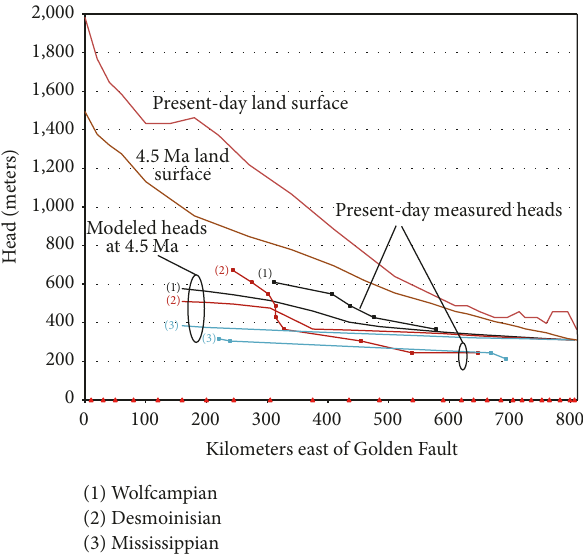
Figure 30: Results of running the fifth model, the 4.5 Ma model, representingthe2.5-million-yearperiodfrom7to4.5 Ma,compared to present-day heads. Model curves (1) , (2) , and (3) (Wolfcampian, Desmoinesian, and Mississippian, resp.) are further approaching the present-day data curves. Red triangles at centroids of the grid columns mark the initial zero heads at 70